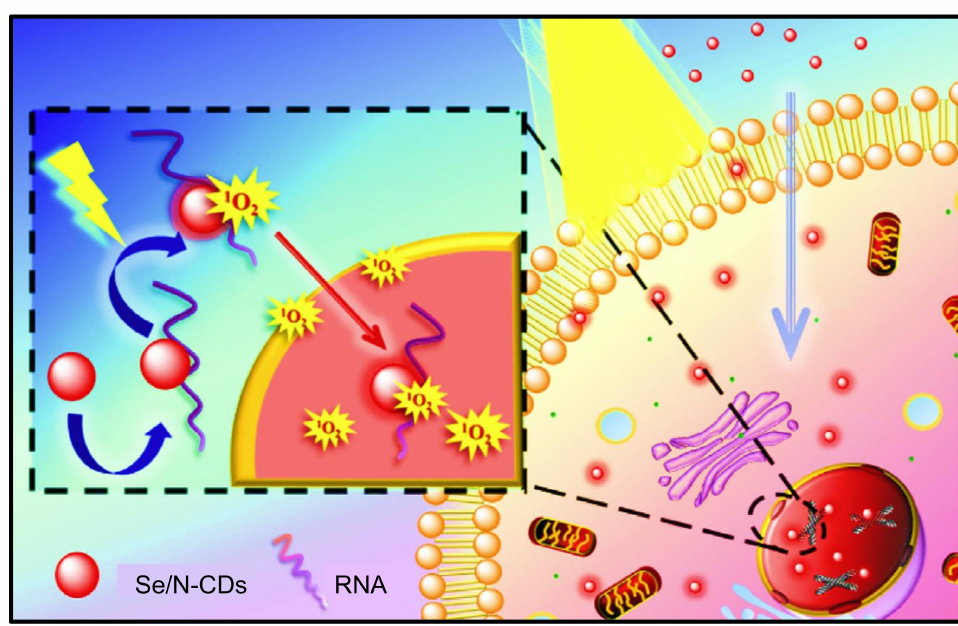
Figure 27. Depiction of an increased photodynamic therapeutic activity by photo-induced Se/N-CDs targeted with RNA. Reproduced from [326], with permission from Elsevier,